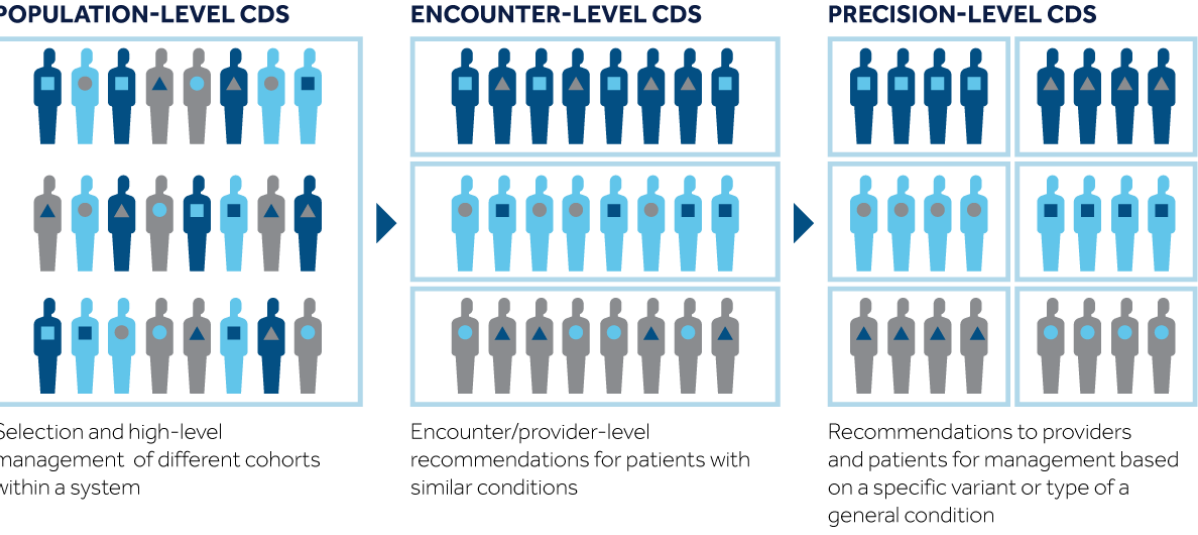
Figure 4. Overview of the integration and relationship of CDS across three domains of health care. CDS: clinical decision